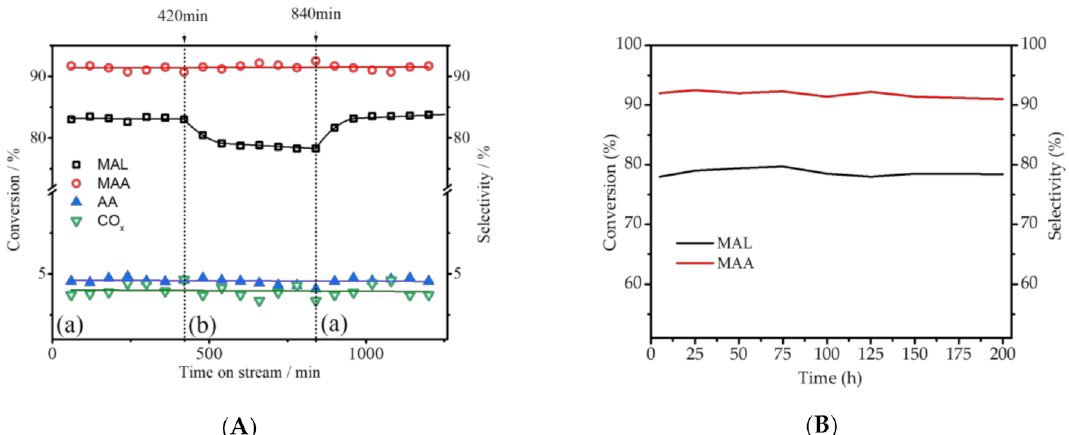
Figure 10. ( A ) Transient response over K 0.6 CuCsNH 4 PVA catalysts with changing the feed from (a) pure MAL to (b) crude MAL at 420 min and subsequently from (b) to (a) at 840 min; ( B ) Long-term performance test with crude MAL for 200 h. Catalysts, K 0.6 CuCsNH 4 PVA; Reaction temperature, 310 ◦ C; Space velocity, 1286 h − 1 , Reaction pressure, atmospheric pressure; Catalyst, 6.001 g, 5 mL; Reactor inlet composition of (a) 3.3% v/v MAL, O 2 content 9.3% v / v , H 2 O content 17.4% v/v and N 2 balance, and (b) 3.3% v/v MAL, 0.06% v/v propanal, 0.08% v/v formaldehyde; O 2 content 9.3% v / v , H 2 O content 17.4% v/v and N 2